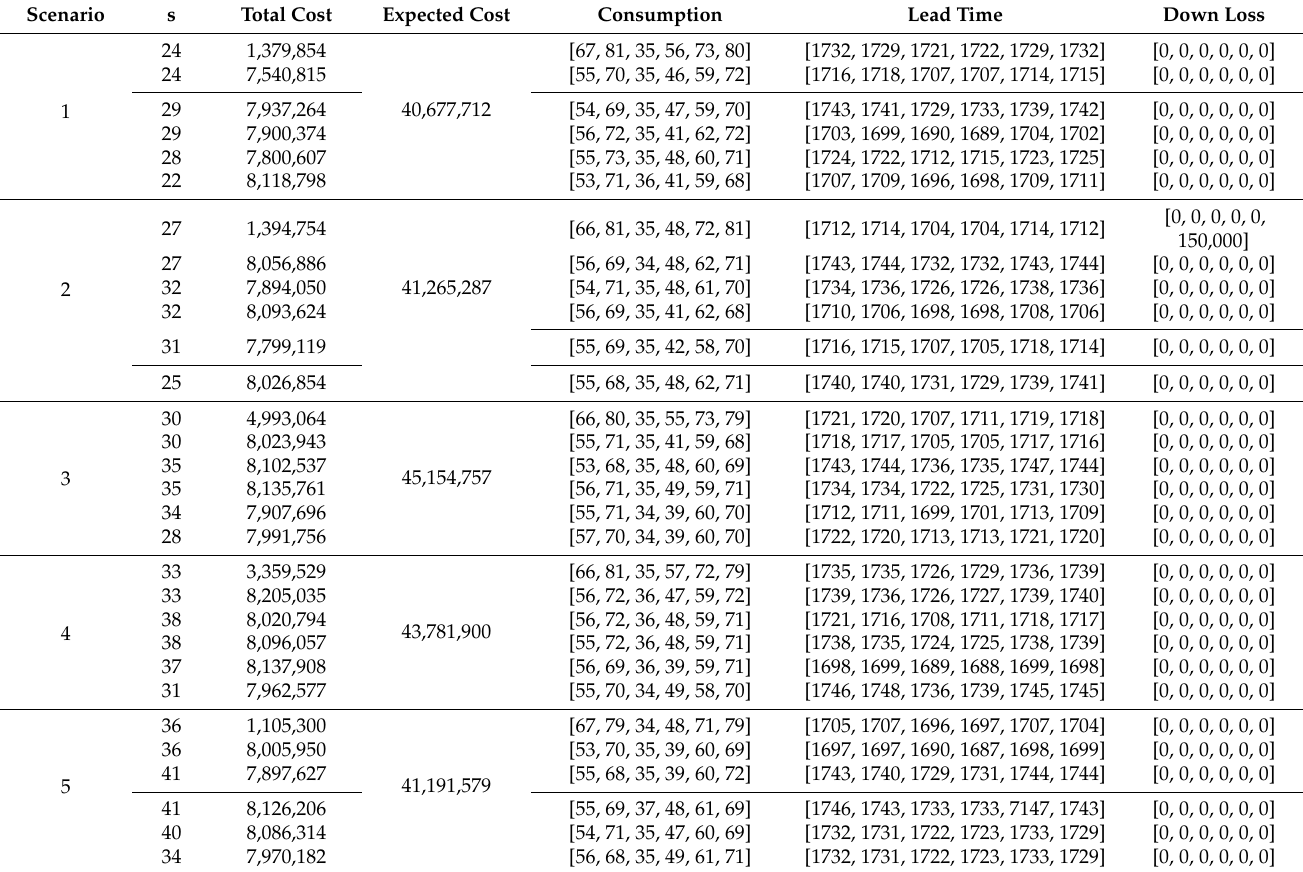
Table A6. Results for different reorder stock